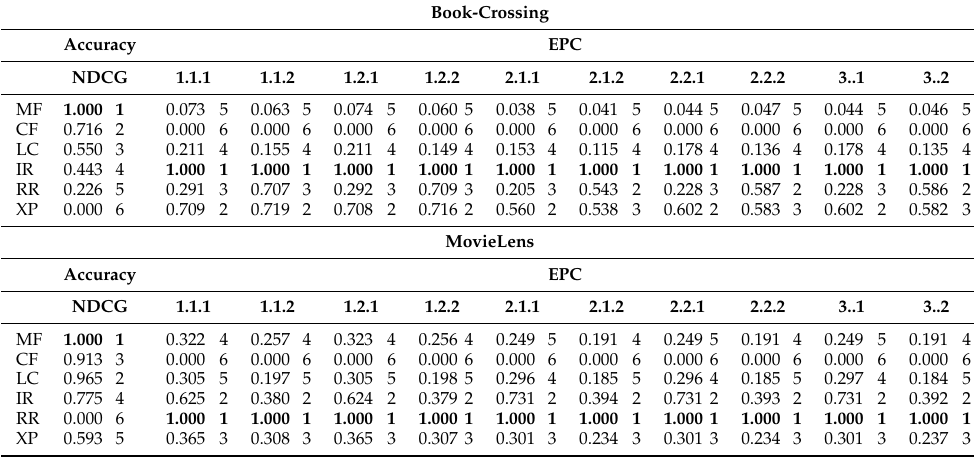
Table 3. Accuracy (NDCG) and novelty (EPC X.Y.Z —please refer to Table 1 for more details) scores of the different algorithms when applying a classical random 10-fold bootstrap process, on the BC and ML datasets. The left part of each column contains the normalized (on the six rows of the column) score, while its right part contains the rank (from 1 to 6) of the algorithm (on the six rows of the